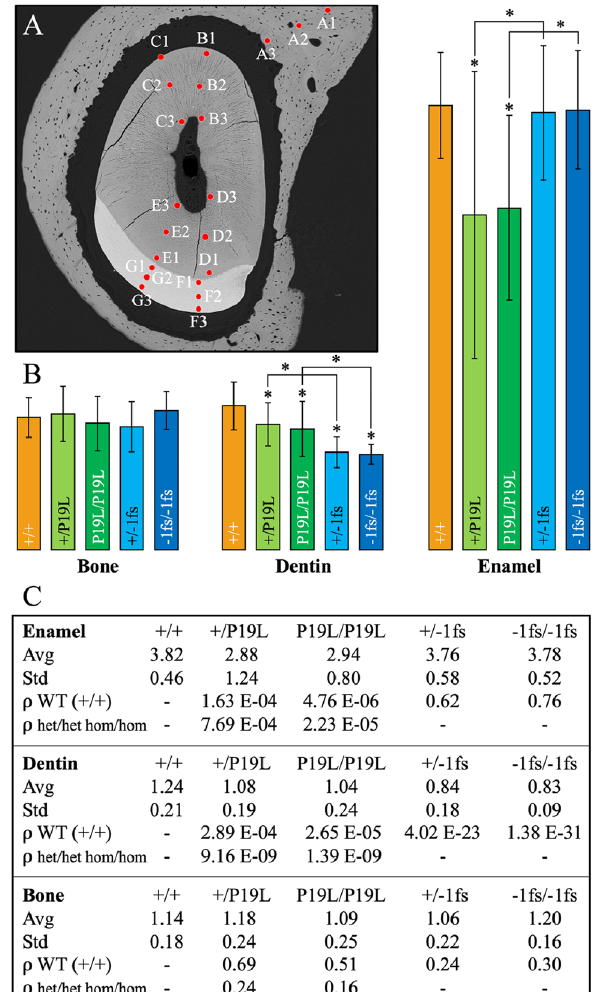
Figure 3. Nanohardness of incisor enamel, dentin and nearby bone in wild-type, Dspp P19L , and Dspp −1fs Mice. ( A ) Red dots show that each sample is indented at 3 positions (A1–A3) in bone, 12 positions (B1–E3) in dentin, and 6 positions (F1–G3) in enamel. ( B ) Bar graph showing the results of nanohardness testing. Asterisks indicate statistical difference (α = 0.05). ( C ) Table showing the results of nanohardness testing in GPa. WT, wild- type; het, heterozygote; hom, homozygote; Avg, average; Std, standard deviation; ⍴ (WT), ⍴ -value as compared to wild-type; ⍴ (het/het or hom/hom), p-value as comparing Dspp + / P19L with Dspp + / −1fs (het/het), or Dspp P19L / P19L with Dspp −1fs / −1fs